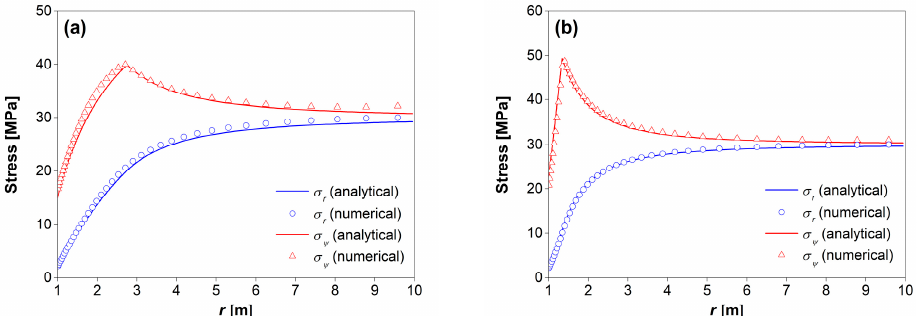
Figure 6. Distributions of the radial and tangential stresses, obtained from the numerical simulations and analytical solutions developed by Li and Aubertin [37] ( a ) for a closed MSDP u surface (with cap) and ( b ) for an open MSDP u surface (no cap).